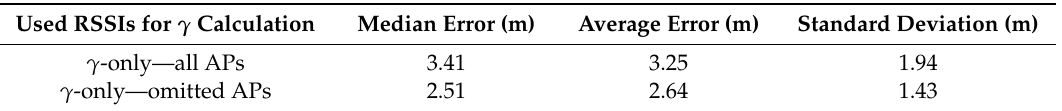
Table 1. Comparison of the mean and median errors made by γ -only method. Used RSSIs for (cid:2237) Calculation